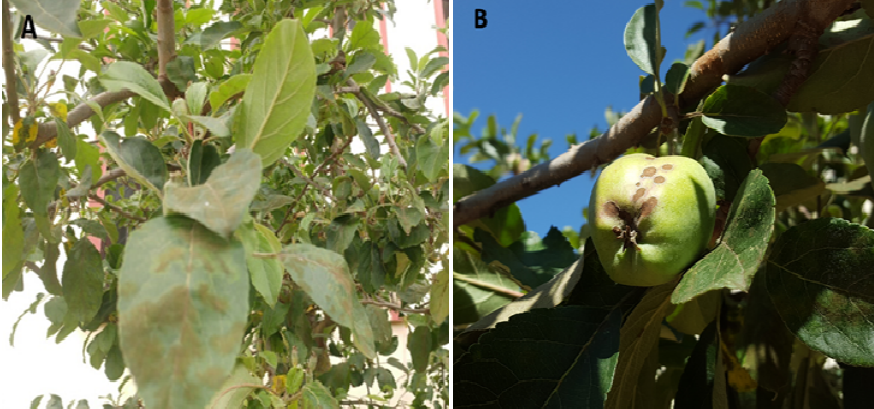
Fig. 1. Symptoms of V. inaequalis , causal agent of apple scab, on leaves (A) and fruit (B) of apple